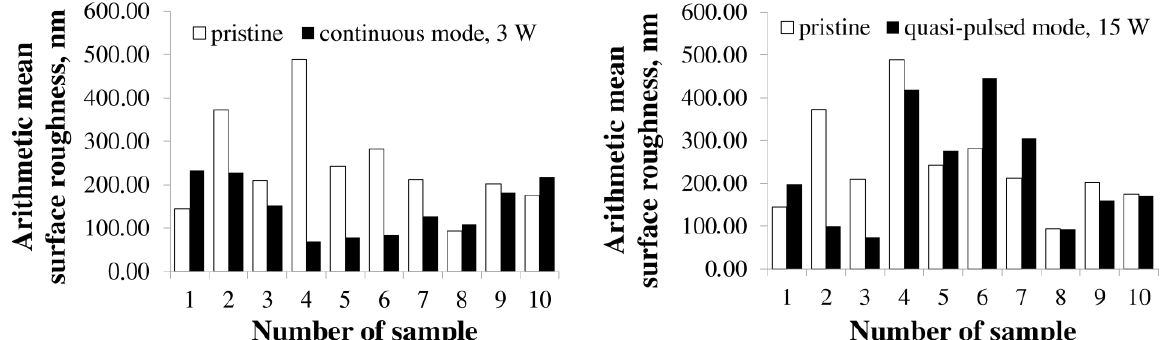
Figure 4. The effect of the composition of 2-component PHAs on the value of the arithmetic mean (Sa) after laser treatment in continuous and quasi-pulse modes (numbering — Table 1): 1 — P(3HB); (Sa) after laser treatment in continuous and quasi-pulse modes (numbering—Table 1): 1—P(3HB); 2 – 4 — P(3HB- со -3HV); 5 – 7 — P(3HB- со -4HB); 8 – 10 — P(3HB- со -3HHx). 2–4—P(3HB-co-3HV); 5–7—P(3HB-co-4HB);